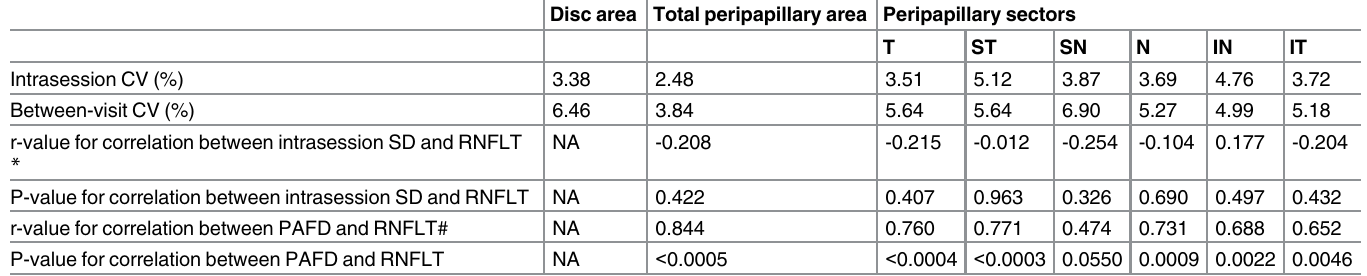
Table 4. Intrasession and between-visit coefficients of variation (CV), correlation coefficients (r) and their significance calculated for the relation- ship between intrasession standard deviation (SD) and the corresponding retinal nerve fiber layer thickness (RNFLT), and peripapillary angioflow vessel-density (PAFD) and the corresponding RNFLT, respectively, in the radial peripapillary capillaries